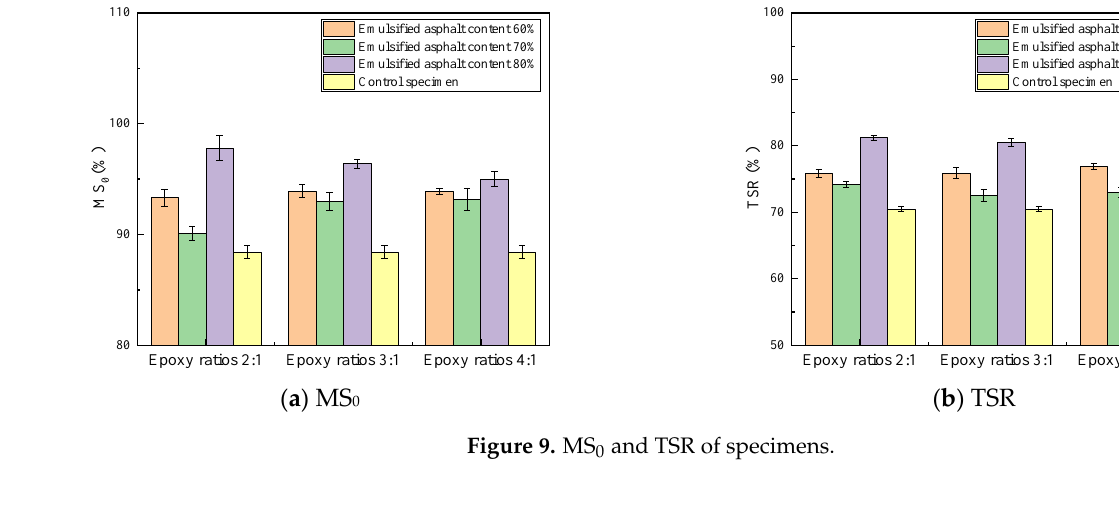
Figure 9. MS 0 and TSR of specimens.